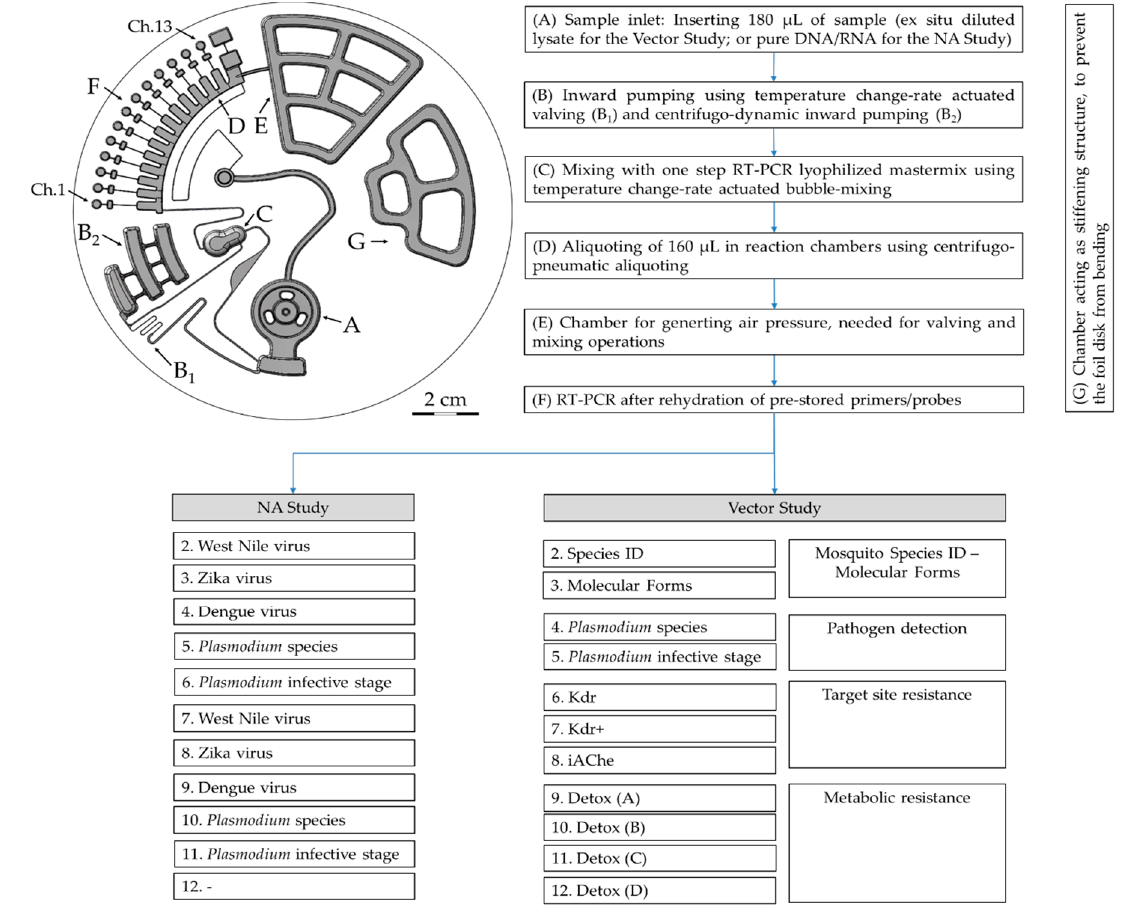
(Figure 3A). In the automated process in the LabDisk, 160 µ L of diluted lysate was transferred radially inwards (B) to the mixing chamber with the lyopellet (C), using temperature change-rate (TCR)